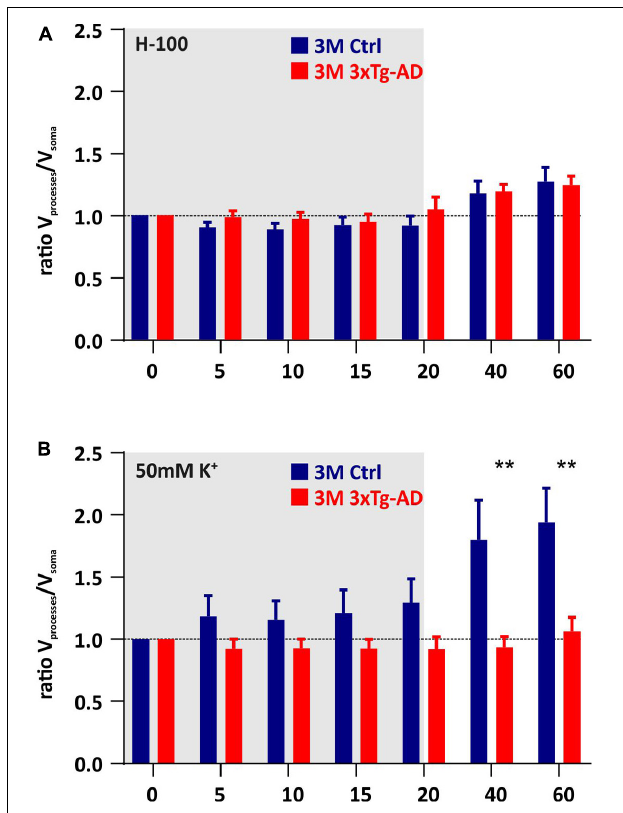
FIGURE 7 | Contribution of cell somas/processes to the total volume changes induced by hypoosmotic stress (A) or hyperkalemia (B) . The bar graph shows the ratio of the change of processes volume to the change in soma. Note that under hyperkalemia, swelling of the processes predominates over the swelling of the somas, in the 3M-old controls, while in the respective age group in 3xTg-AD mice the somas and processes swell comparatively. Data are presented as mean ± SEM. Statistical significance was determined by two-way ANOVA test with Tukey’s post hoc test. Asterisks indicate significant differences (** p < 0.01). Ctrl, control; 3xTgAD, triple transgenic model of AD crossbred with GFAP/EGFP mice; GFAP, glial fibrillary acidic protein; EGFP, enhanced green fluorescent protein; H-100, hypotonic artificial cerebrospinal fluid; 50 mM K+, artificial cerebrospinal fluid with elevated K+ concentration; 3M, 3-month-old